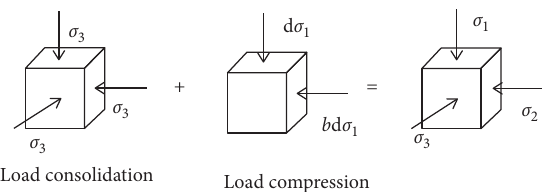
Figure 4: Sketch map of the loading